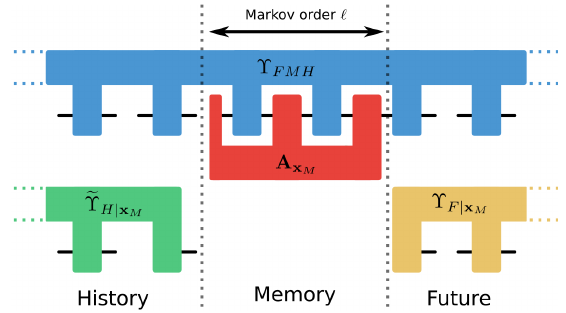
FIG. 32. Quantum Markov order. If a process ϒ FMH has finite Markov order with respect to an instrument and tester J M = } on the memory block, then the application of each of the { A x M elements of J M leaves the process in a tensor product between future F and history H